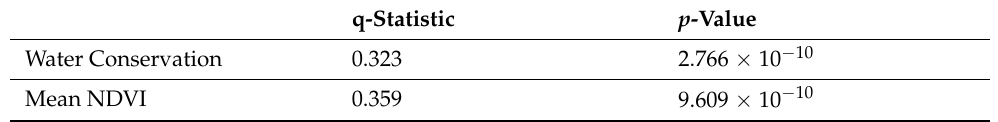
Table 2. Factor detector between water conservation and ecosystem